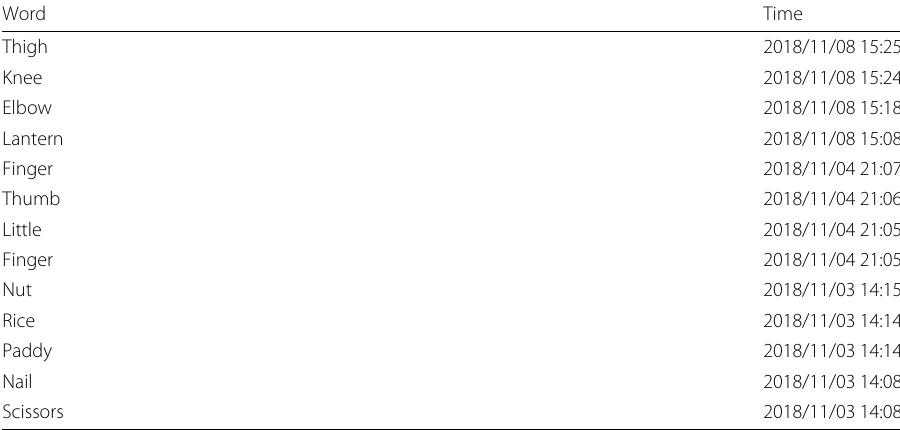
Table 1 Learner’s vocabulary and time of